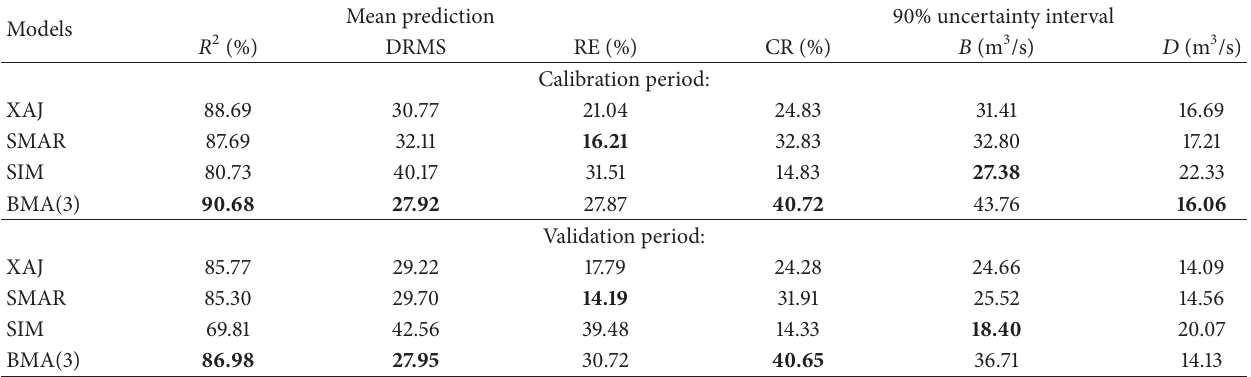
Table 1: Results of BMA(3) and its 3 individual models in the mean prediction as well as 90% uncertainty interval for the whole flow series.